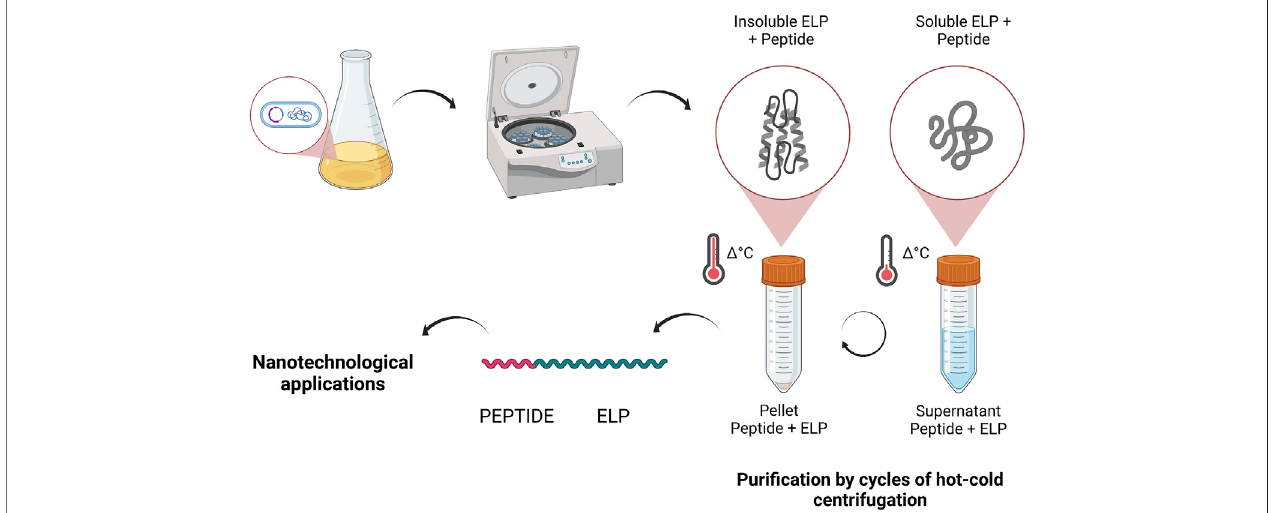
FIGURE 1 | Heterologous expression of ELP fused with proteins or peptides and the puri fi cation process for hysteresis, due to their characteristic Tt, which is separated based on insoluble or soluble ELPs by centrifugation of the other proteins. Created with BioRender.com.